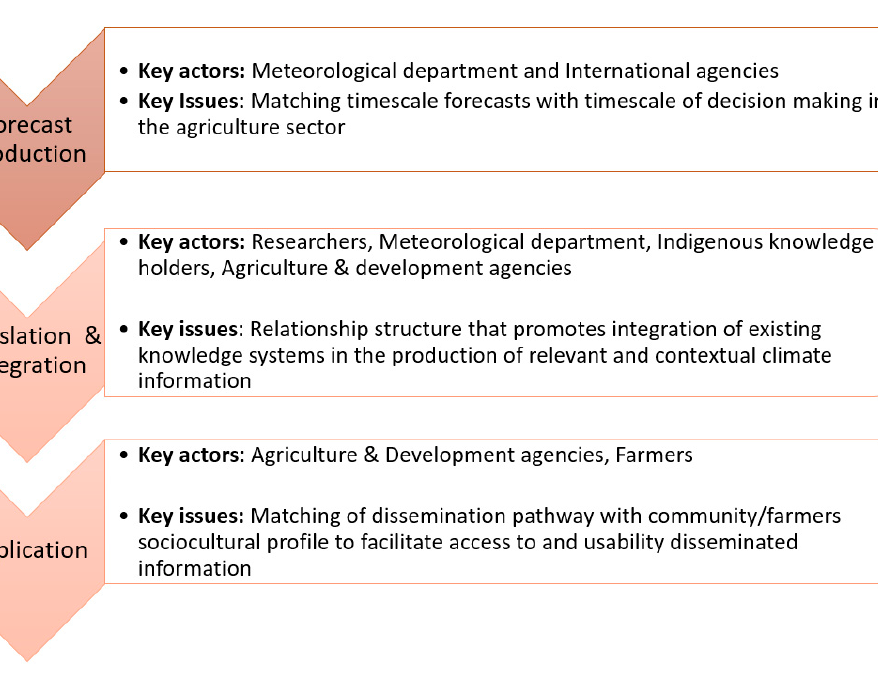
Figure 3. CS value chain characterizing phases of forecast production and translation climate infor- mation.